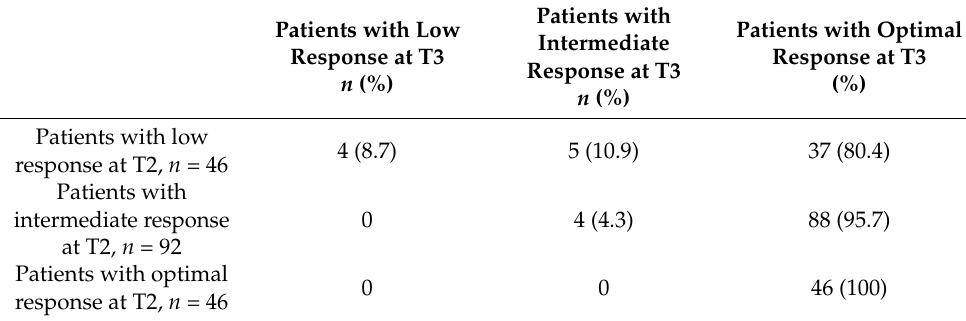
Table 4. Description of longitudinal evolutions of humoral response at T3 according to response at T2. Data are expressed as absolute number and as percentage respect to the relative frequency. The same quartile limits in BAU/mL were applied both at T2 and at T3.